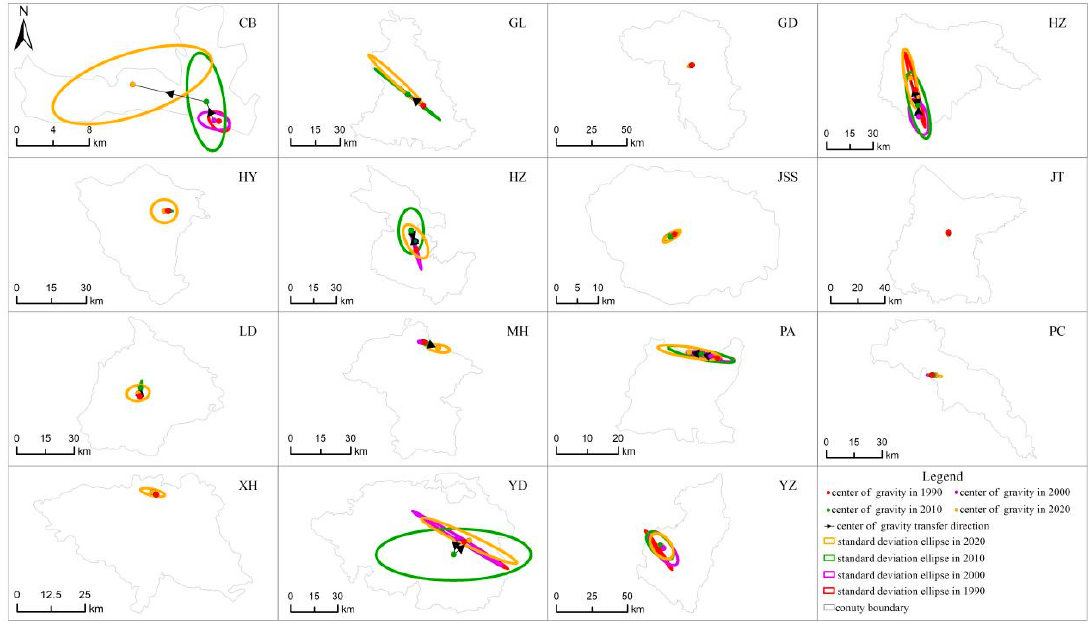
Figure 5. Distributions of central construction land shifts at the county level in the study area from 1990 to 2020.